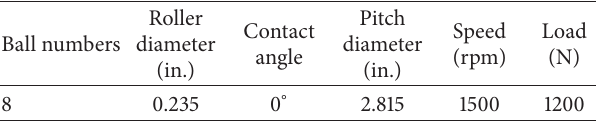
Table 1: Parameters of the test rolling bearing.